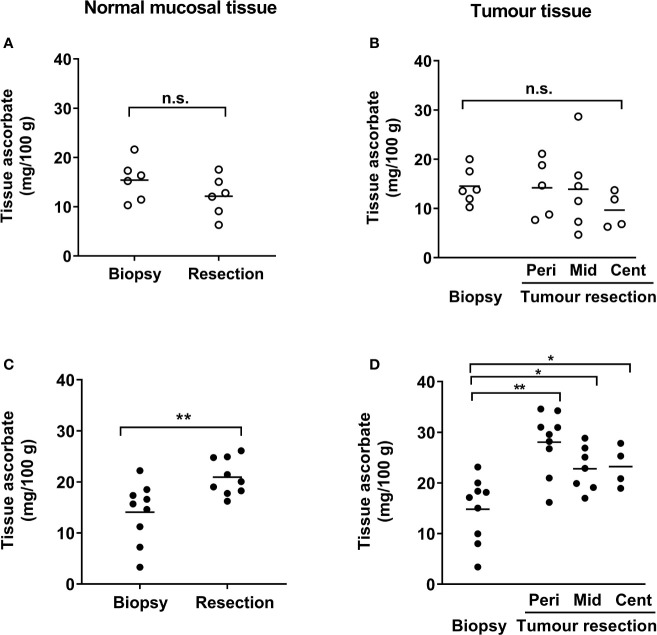
Ascorbate levels in patients with colorectal cancer in normal mucosa and in tumor tissue. Tissue levels in control (A, B) and infusion patients (C, D), with samples taken at diagnostic colonoscopy and after resection. Ascorbate levels were unchanged in normal mucosa (A) and in tumor tissue (B) from control patients, but were significantly increased in both normal mucosa (C) and tumor tissue (D) following infusions. Tumor lesions were sampled at multiple locations as follows: edge/periphery (Peri), mid-tumor (Mid) and central core (Cent). Not every part of the tumor was sampled in every patient and hence sample numbers may vary for the tumor regions (B, D). Individual data for control (n ≤ 6) and infusion cohorts (n ≤ 9) with means are shown. Results were compared using paired t-tests for changes following infusion, as shown. *p < 0.05, **p < 0.01, n.s., not significant.